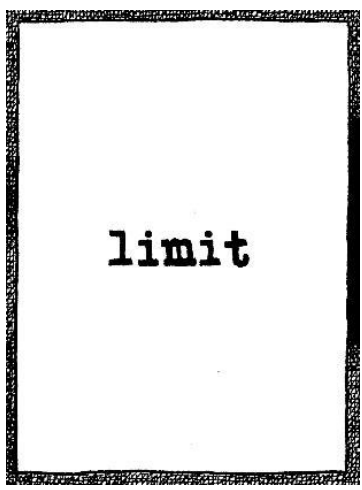
Figure 5. From Cotter, Nod Away , 22. Copyright, 2016, Joshua W